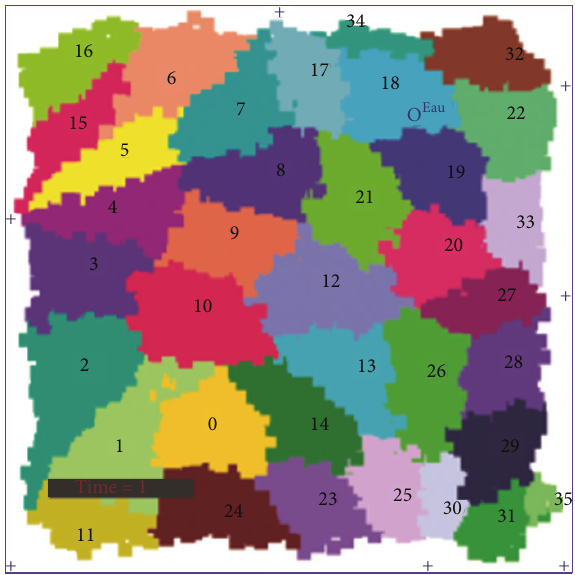
Figure 11: Assignment of dedicated place cell fields. Permission for replication given by Dr. Cuperlier et al. [24].